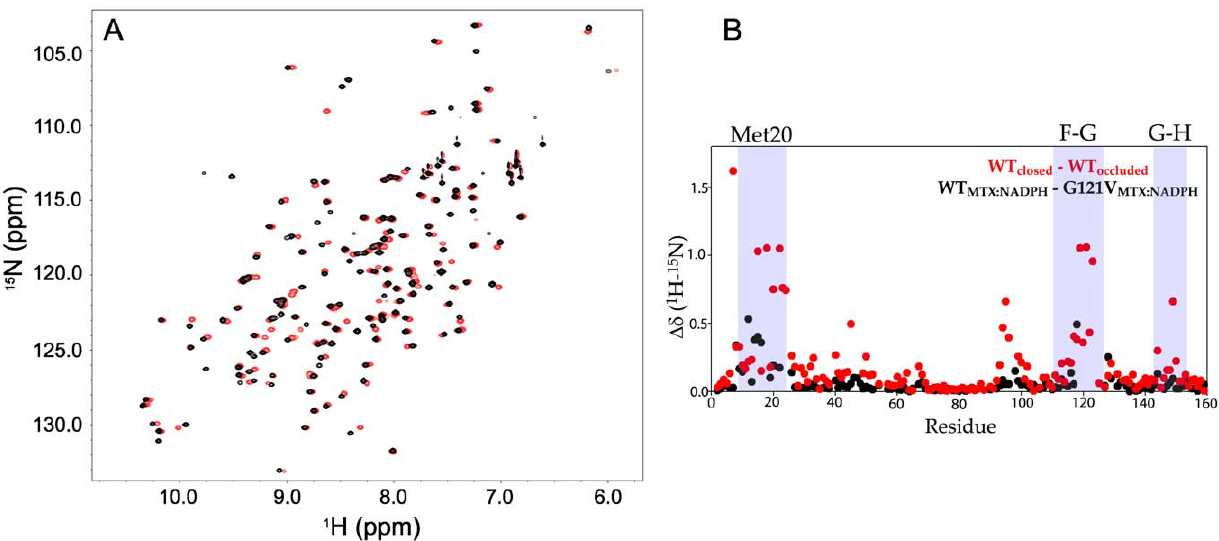
Figure 2. Methotrexate binding traps G121V in the closed conformation. (A) 1 H– 15 N HSQC spectra of E:NADPH:MTX (black) overlain with the 1 H– 15 N HSQC spectra of E G121V :NADPH:MTX (red). (B) The reduced change in chemical shift is calculated using the following formula and is q ffiffiffiffiffiffiffiffiffiffiffiffiffiffiffiffiffiffiffiffiffiffiffiffiffiffiffiffiffiffiffiffiffiffiffiffiffiffiffiffiffiffiffiffiffiffiffiffiffiffi . The changes as a result of mutation (G121V vs. WT) are subsequently plotted as a function of residue number: D d ~ 0 : 1 | D d 15 N ð Þ 2 z D d 1 H ð Þ 2 shown in black and a bona fide closed–occluded change are plotted in red [23]. The plot shows that the pattern of changes as a result of mutation can be attributed to differences in the local chemical environment and not large-scale structural change. The Met20 (residues 9–23), F–G (residues 117–131), and G–H (residues 142–149) loops are highlighted.